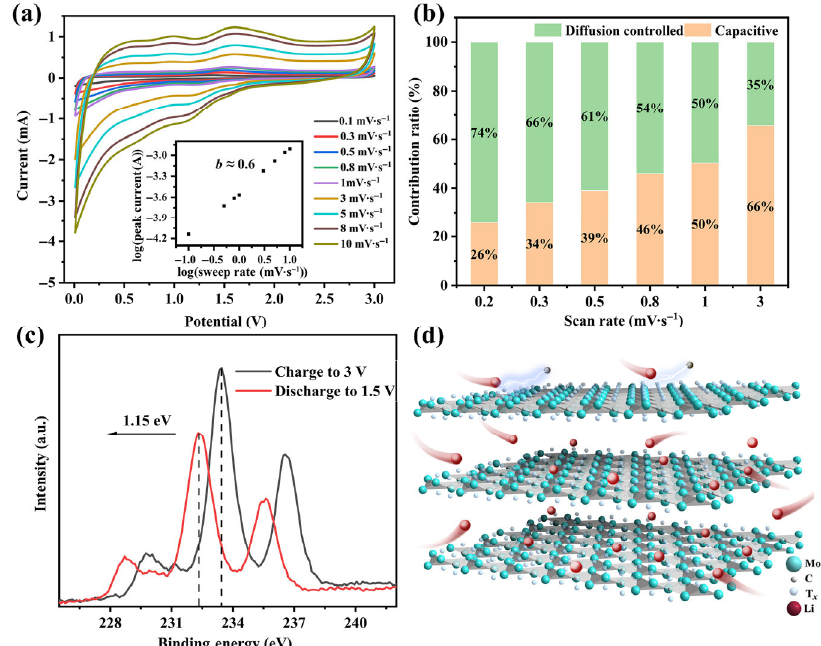
Figure 4 Study on the kinetics and mechanism of Mo 1.33 CT x electrode during charge and discharge process. (a) CV curves of Mo 1.33 CT x at different scan rates from 0.1 to 10 mV·s −1 . Inset: function of log i and log v in anodic peak current. (b) Contribution of capacitance to capacity at different scan rates from 0.1 to 3 mV·s −1 . (c) High-resolution XPS spectra of Mo 3d at charge to 3 V and discharge to 1.5 V. (d) Schematic diagram of lithium ions storage in Mo 1.33 CT x